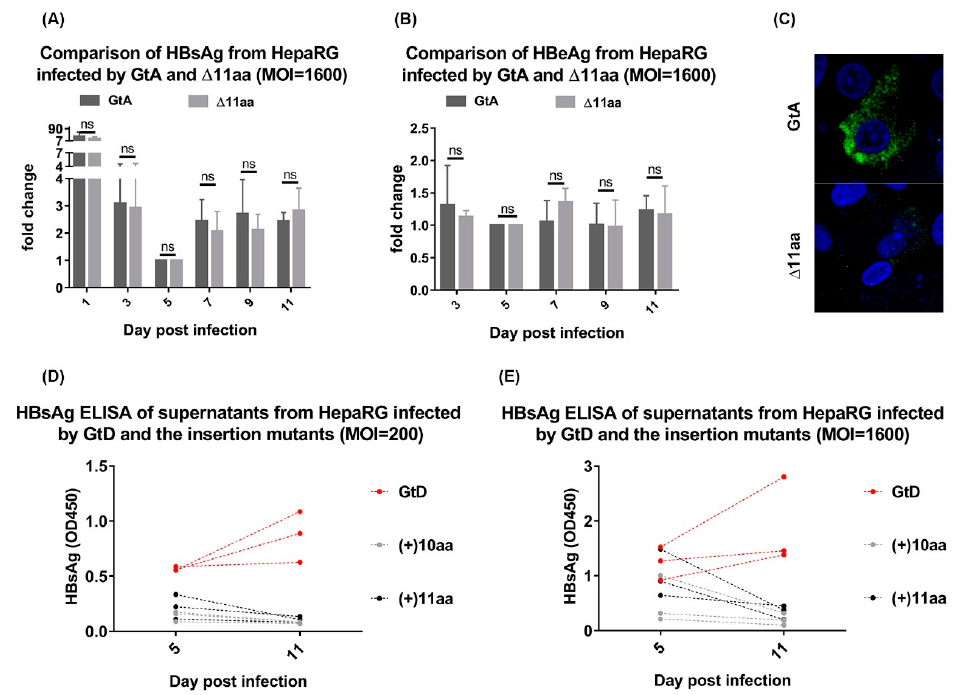
Figure 5. Deletion of 11 aa in the N-terminal part of GtA PreS1 has no impact on viral infectivity. ( A – C ) Di ff erentiated HepaRG were infected with HBV from GtA and GtA_ ∆ 11aa at multiplexity of infection (MOI) 1600. Culture supernatants collected at indicated time points were analyzed by HBsAg ELISA (5A) and HBeAg ELISA (5B). The lowest signals (5 days post-infection) were standardized as 1. The cells were fixed and analyzed by CLSM using the MA18 / 7. ( D , E ) Di ff erentiated HepaRG